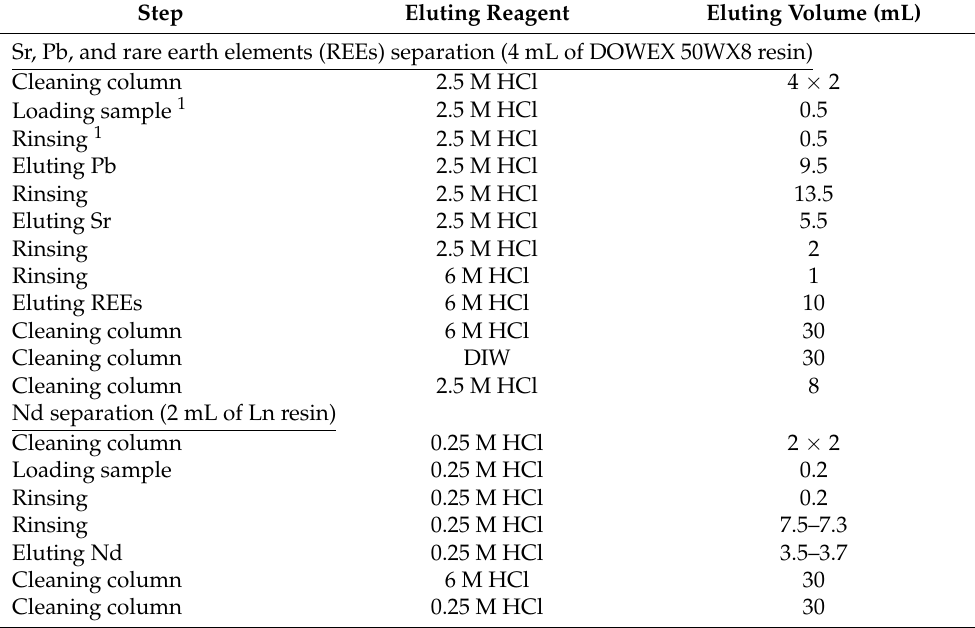
Table 1. Sr–Nd purification